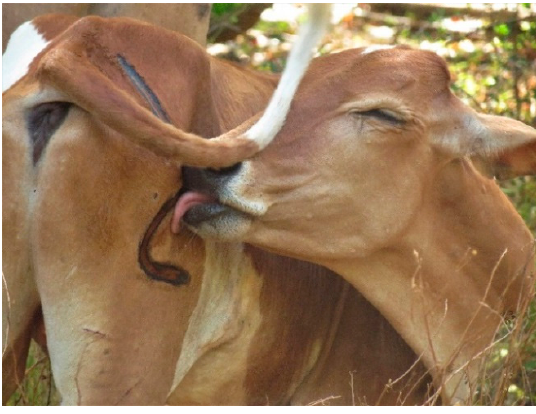
Figure 4. Animals were observed licking the brand immediately after the procedure.